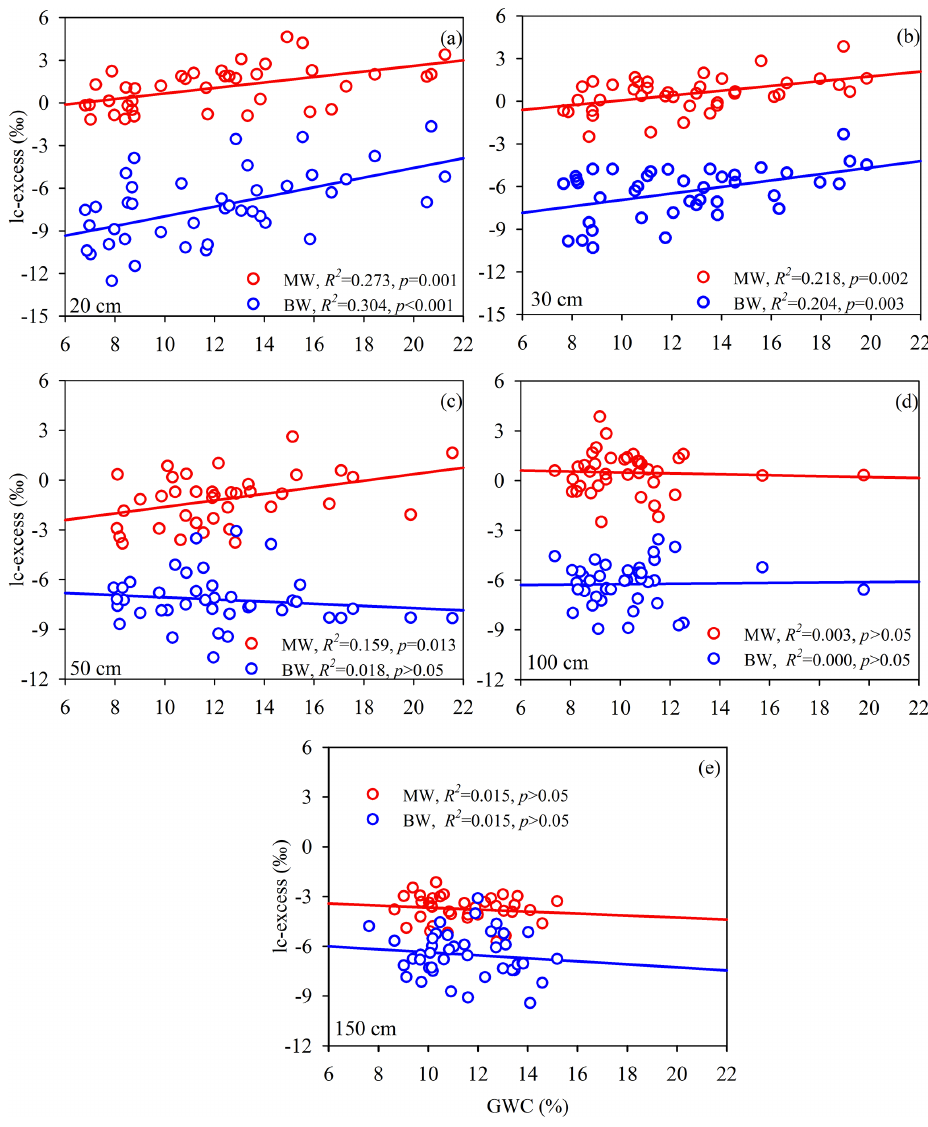
Figure 4. Relationships between gravimetric water content (GWC) and (a) lc-excess values at 20cm depth, (b) lc-excess values at 30cm depth, (c) lc-excess values at 50cm depth, (d) lc-excess values at 100cm depth and (e) lc-excess values at 150cm depth. Values of lc-excess for mobile water (MW) and bulk soil water (BW) are shown as red and blue circles, respectively. The insets summarize the goodness of fit of the linear